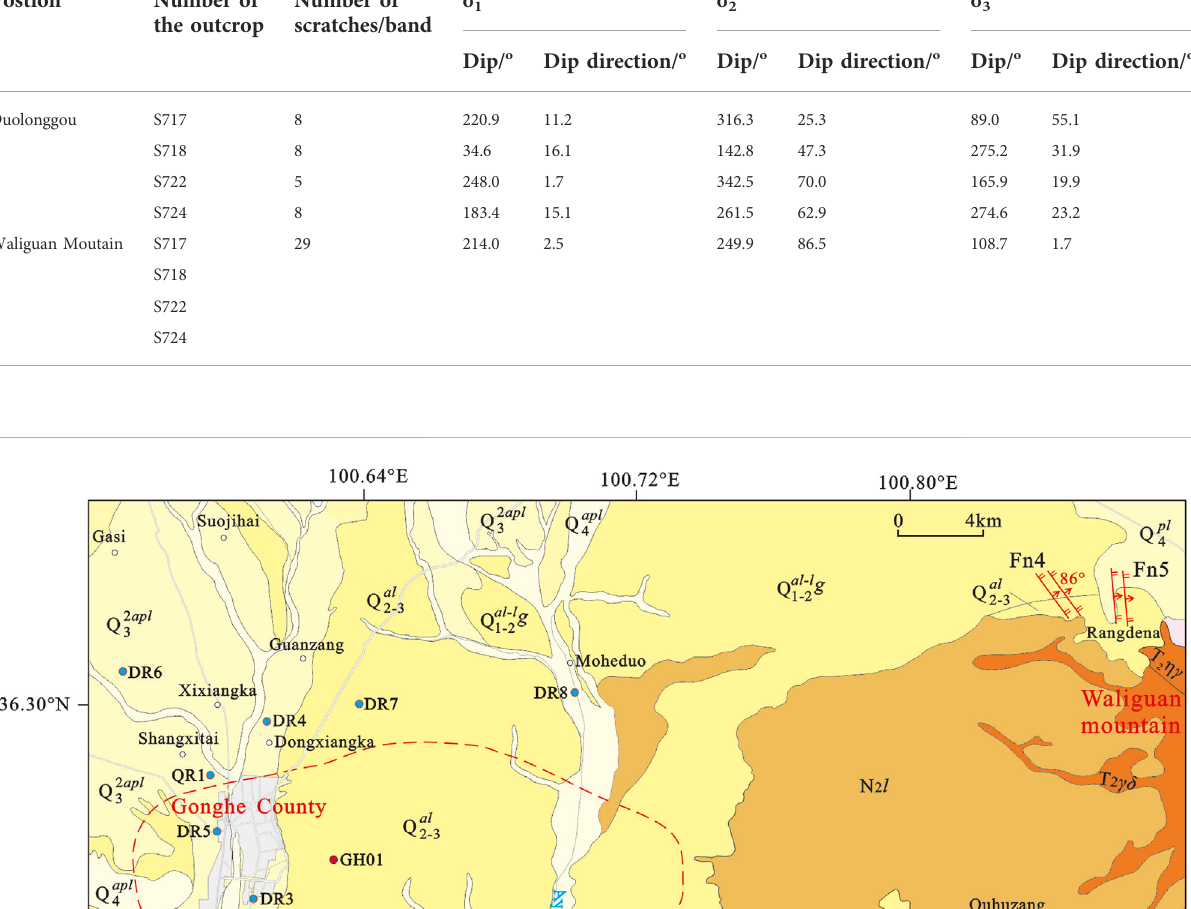
TABLE 1 Results of the tectonic stress fi eld re fl ection using fault slickensides in the southern Duolonggou Arc Fault. Postion